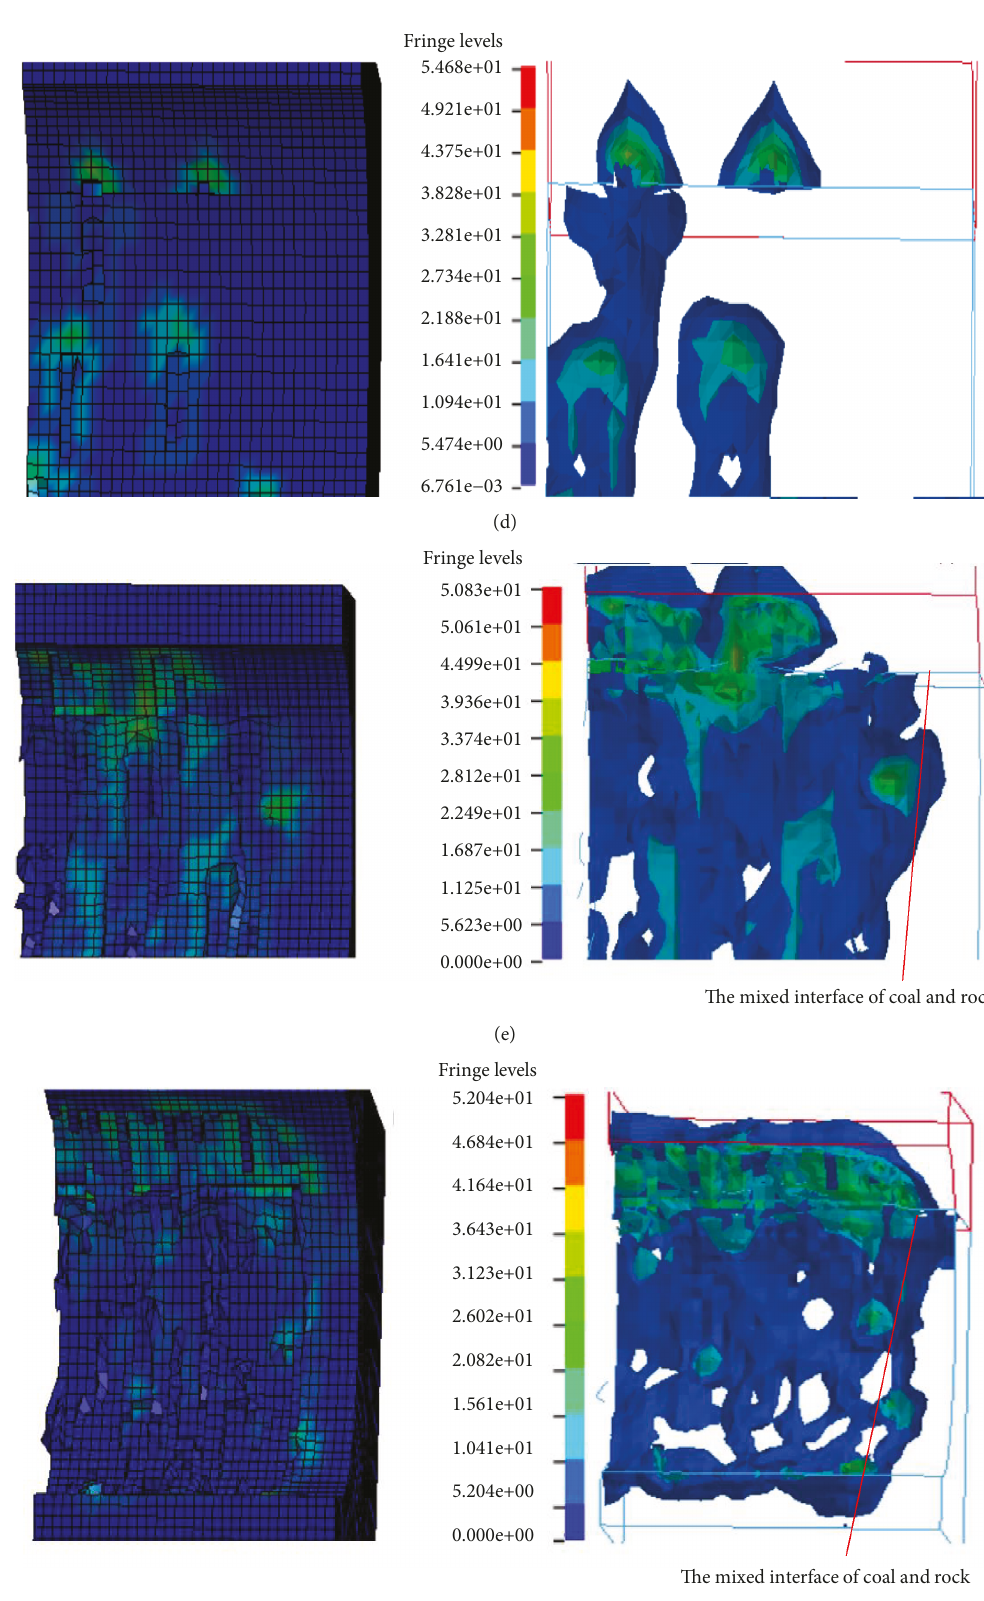
Figure 4: The process of the change of the coal and rock plastic